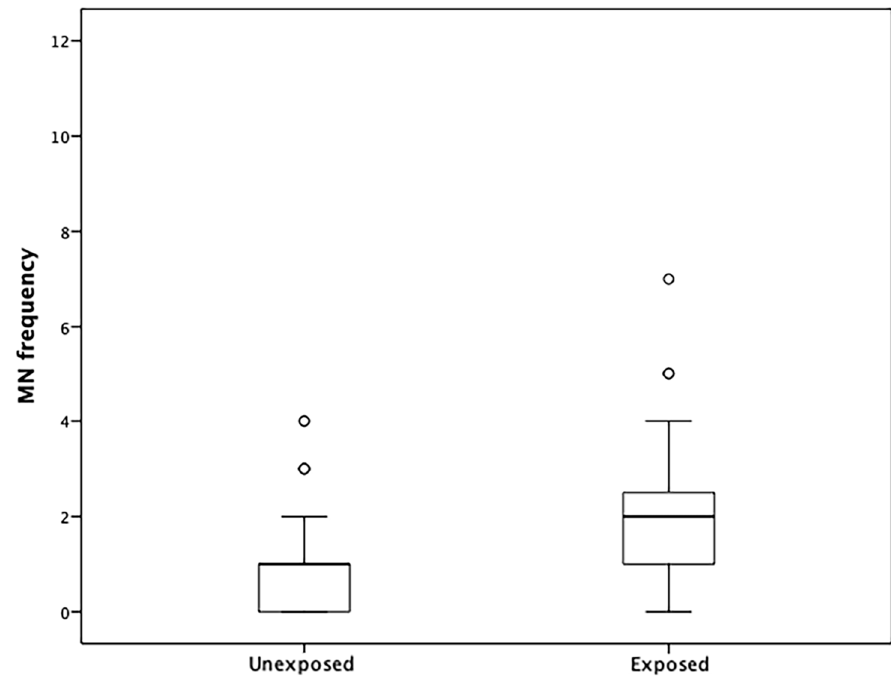
Figure 1. Graphic representation of MN frequency distributions in unexposed and exposed groups. Circles indicate outliers, bars indicate percentile values, and lines indicate minimum and maximum standard deviations. Table 4. Correlations among repetitive sequence LINE-1 methylation, MN frequencies, and construction environment by Poisson regression analysis.